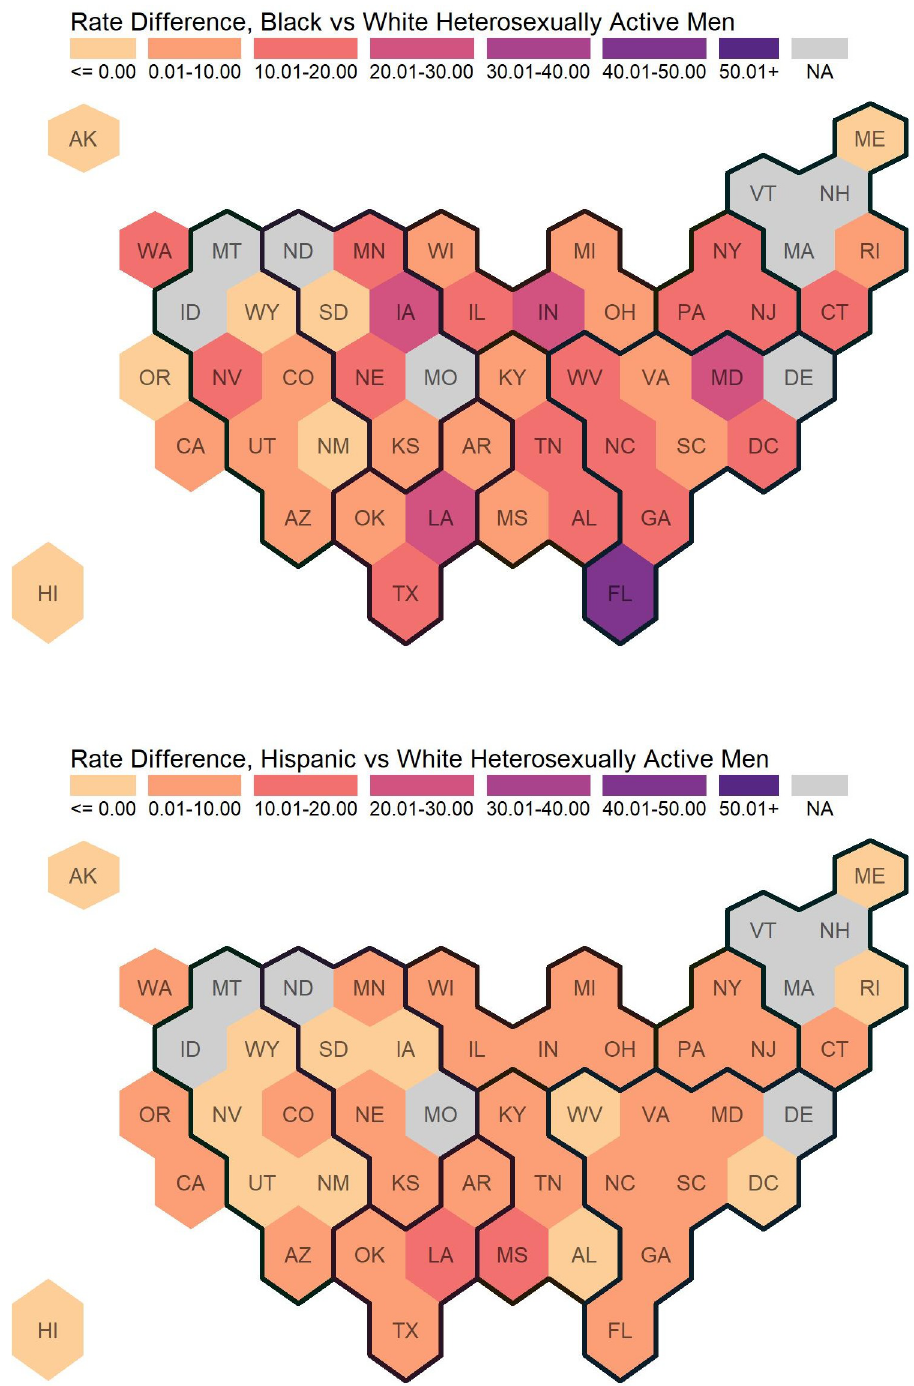
Fig 2. Rate differences of newly diagnosed HIV cases among heterosexually active Men Ages 18+. Regions are indicated with the dark black lines. Eight states did not report stratified data (by sex, transmission category, and race/ ethnicity), and are indicated with “not available”